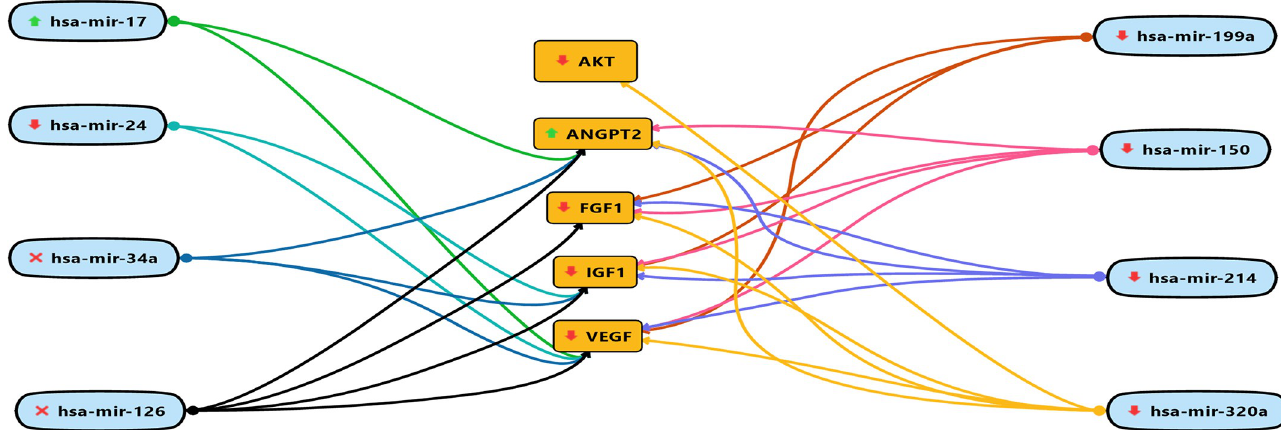
Fig 5. mRNA-miRNA interaction map. The upward green arrows show, up-regulation of circulating miRNAs during DCM. The downward red arrows show, down-regulation of circulating miRNAs during DCM. Whereas, the red cross show unavailability of circulating miRNAs during DCM. The red downward arrow shows the down-regulation of genes and the green upward arrow for up-regulation of